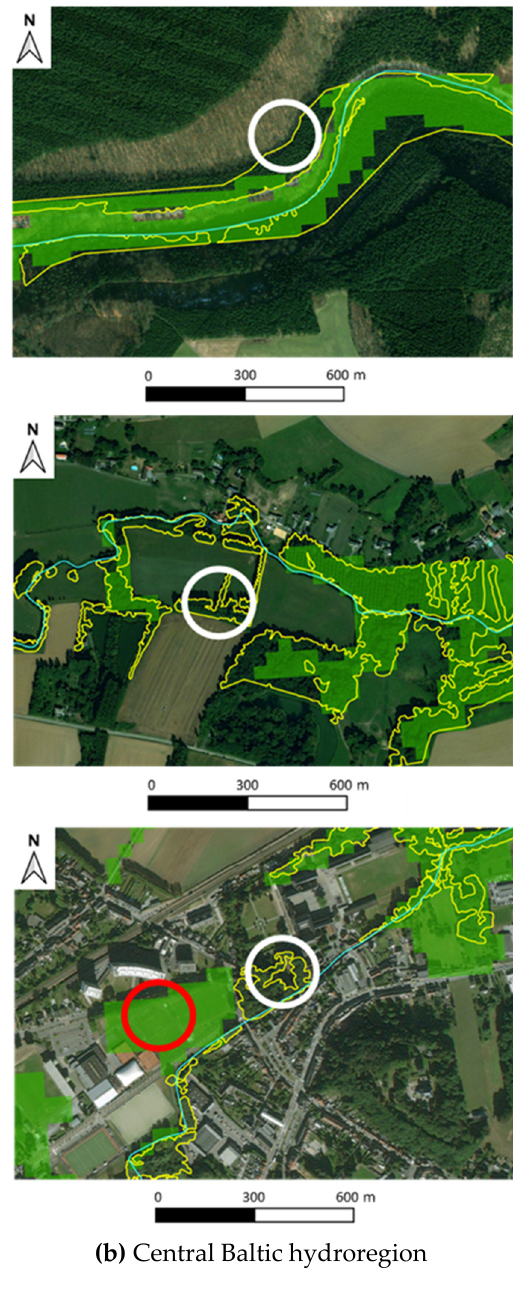
Figure 4. Least, Moderately and Highly Disturbed Sampling Units in the a) Mediterranean and b) Central Baltic hydroregions (light blue line — river segment; green areas — Copernicus Actual Riparian Zone (ARZ); yellow polygons — Manual Riparian Zone (MRZ); red circles — “false positive” misclassification; white circles — “false negative” misclassification).